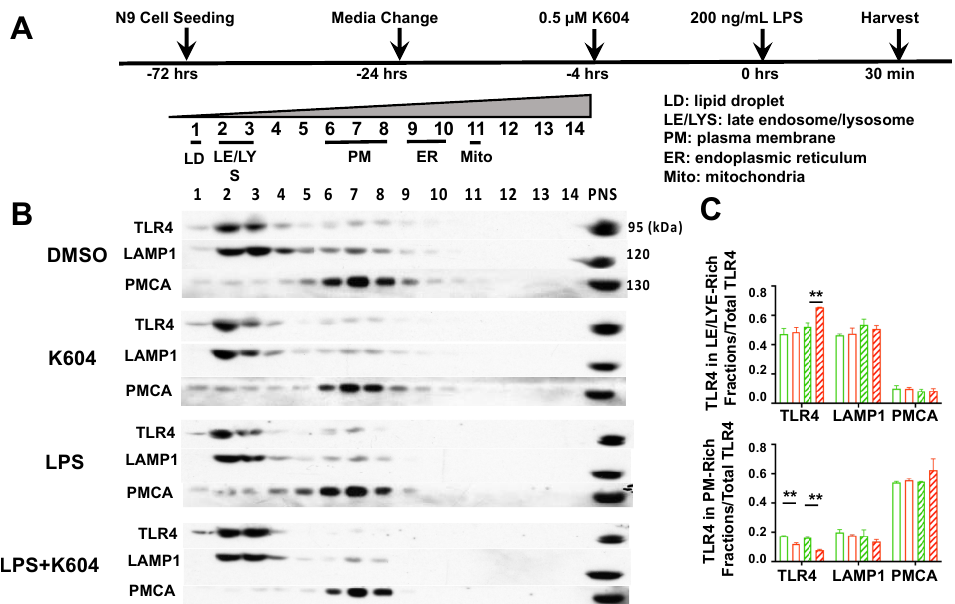
Figure 4. ACAT1 inhibition by K604 causes TLR4 enrichment in late endosome/lysosome in N9 cells acutely treated with LPS. ( A ) Experimental design and organelle marker distribution patterns after OptiPrep TM density gradient ultracentrifugation using the post-nuclear supernatant (PNS) of N9 cell homogenates at far-right lane. Cells were treated with or without LPS from 30 min. ( B ) Fractions were analyzed for TLR4 content as well as for late endosome/lysosome marker LAMP1 and plasma membrane marker PMCA (plasma-membrane-type Ca2+-ATPase). ( C ) TLR4 in LE/LYE-rich fractions and in PM-rich fractions vs. total TLR4 were calculated. n = 3 replicates, ** p < 0.01. Treating cells with K-604 followed by LPS treatment for 30 min significantly increased the content of TLR in the LE/LYS fractions (Figure 4C, top panel). In addition, treating cells with A1B decreased TLR4 by 50% in the PM, both with and without LPS (Figure 4C, bottom panel). These results show that pre-treatment with A1B causes more TLR4 to accumulate